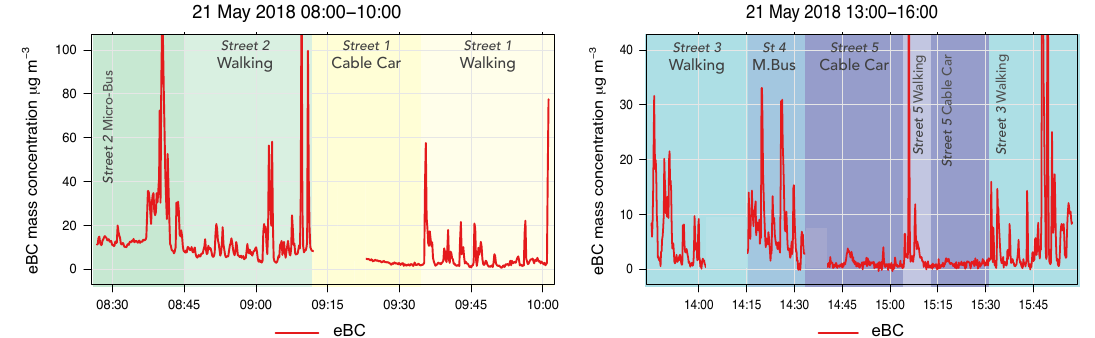
Figure 4. Sample time-series for cable car, walking and microbus measurements corresponding to round (going + return) morning and afternoon trips from two cities: ( left ) La Paz and ( right ) El Alto. Note the di ff erent scales of eBC mass concentration in the two cities. Background color indicates the location of the experiment and the time spent per mode of travel. Missing data on the time series were the omitted data due to waiting times to get inside the cable car and / or microbus